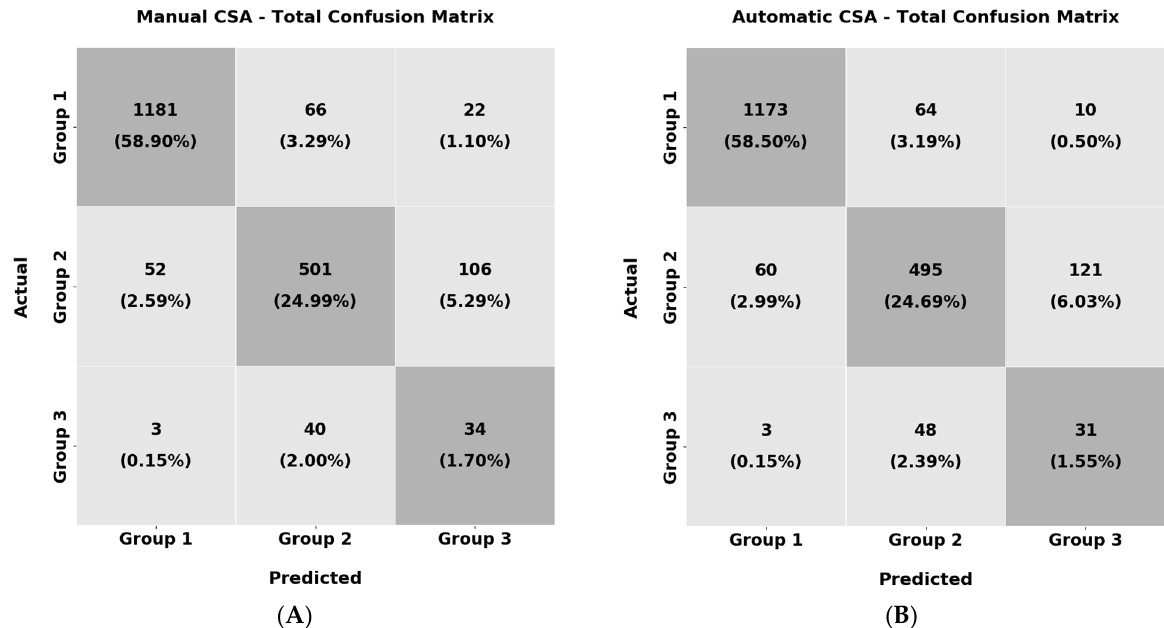
Figure 13. Confusion matrices for the per-group analysis. In ( A ), the manually extracted CSA textures were used and in ( B ), the automatic were used.